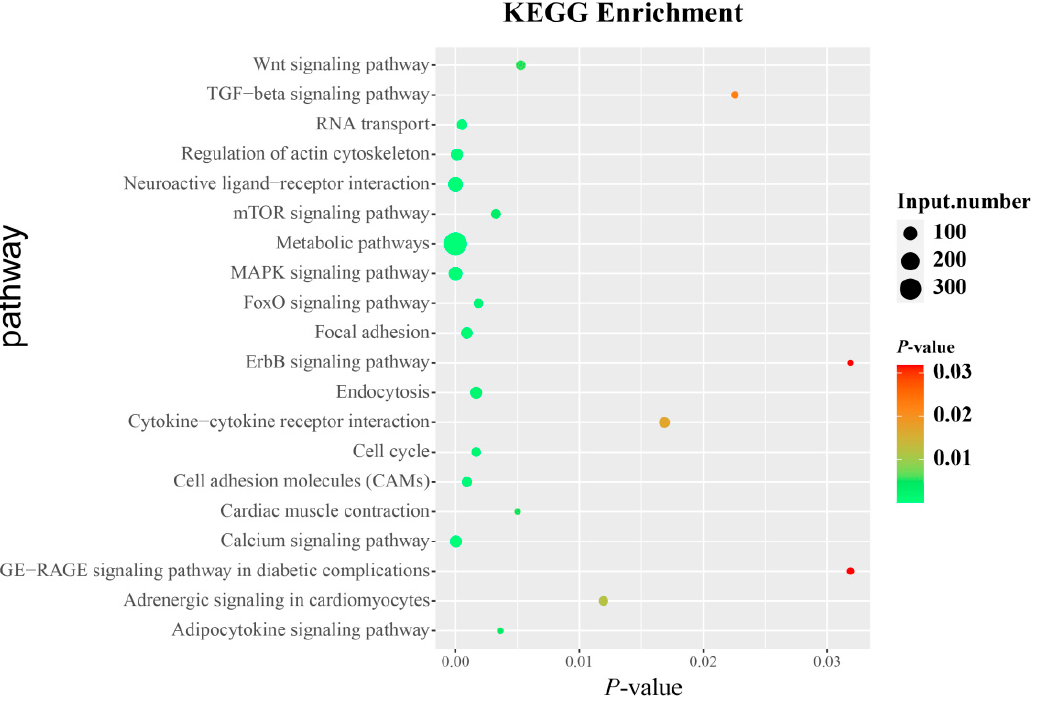
Figure 7. Kyoto Encyclopedia of Genes and Genomes (KEGG) analyses of annotated genes at the top 1% SNPs. The picture shows 20 KEGG pathways. Y represents the pathway, and X represents the rich factor. Size and color of the bubble represent the amounts of differentially expressed genes enriched in the pathway and the enrichment significance, respectively. The top 1% of SNPs were derived from the results of the genome-wide association study, and the analyzed individuals contained selection line: 252, control line: 268.